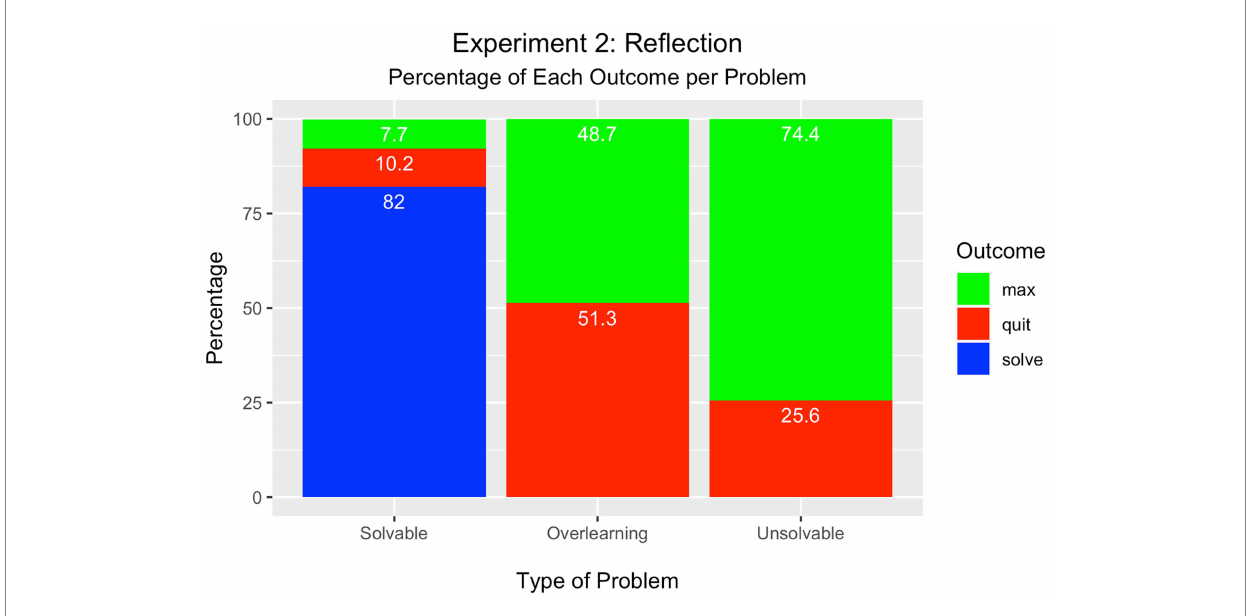
FIGURE 3 Experiment 2 – Reflective Effort